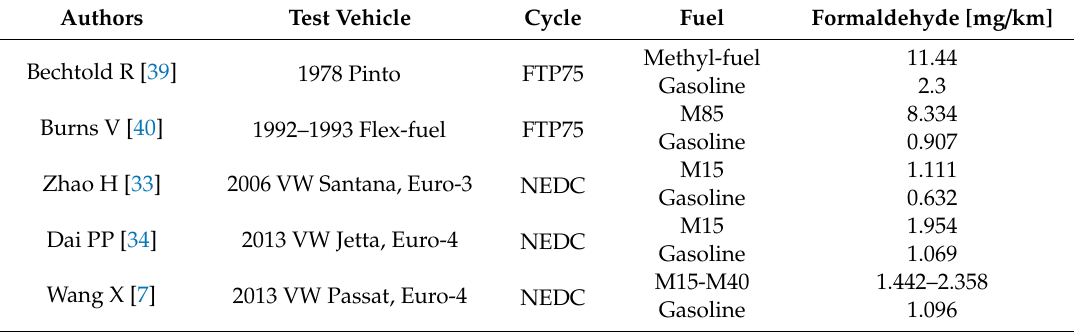
Table 3. Formaldehyde emissions from gasoline vehicles reported in previous publications.